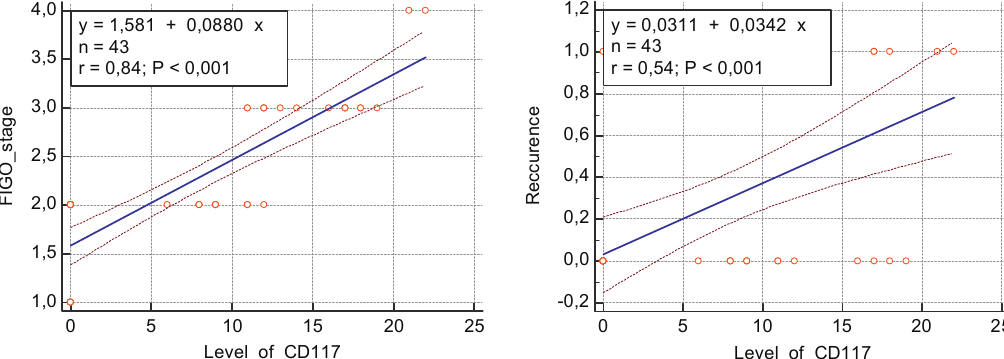
Fig. 4. Graphic representation of the relationship between CD117 expression and disease stage (left) and relapse